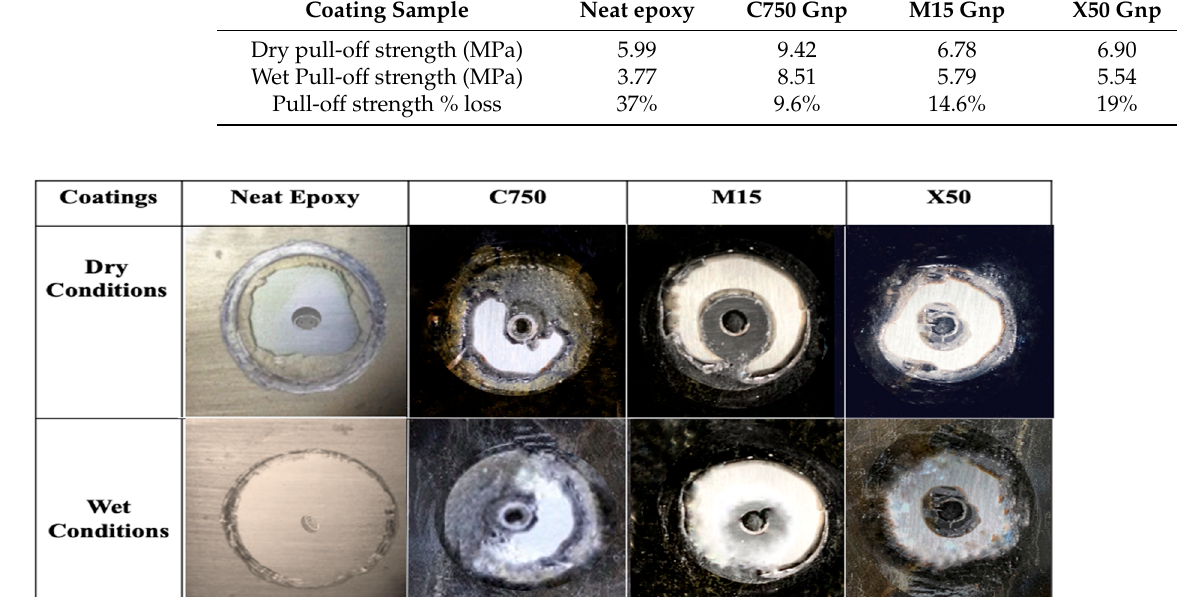
Figure 5. Optical images of epoxy and Gnps/epoxy composite coatings under dry and wet conditions of pull–off adhesion testing against of time.